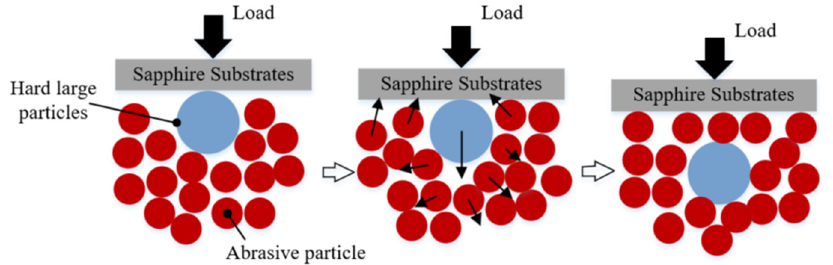
Figure 3. Schematic diagram of “trap” effect of semi-fixed abrasives during polishing.